Question: Summarize what this figure shows in one sentence.
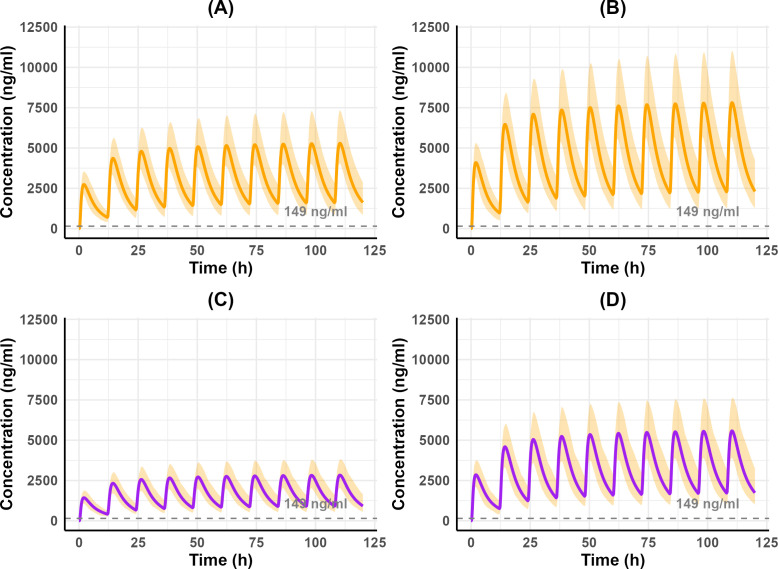
Answer: PBPK model simulations of GST-HG171/ritonavir in subjects with renal impairment. Simulated plasma concentrations of GST-HG171 in a virtual adult population (50% female) with mild or moderate renal impairment after 5 consecutive days of twice-daily co-administration with ritonavir. Solid lines represent mean concentrations, and shaded areas represent the 5th–95th percentile range. Simulation scenarios: ( A ) 100/100 mg in mild impairment, ( B ) 150/100 mg in mild impairment, ( C ) 50/100 mg in moderate impairment, and ( D ) 100/100 mg in moderate impairment.